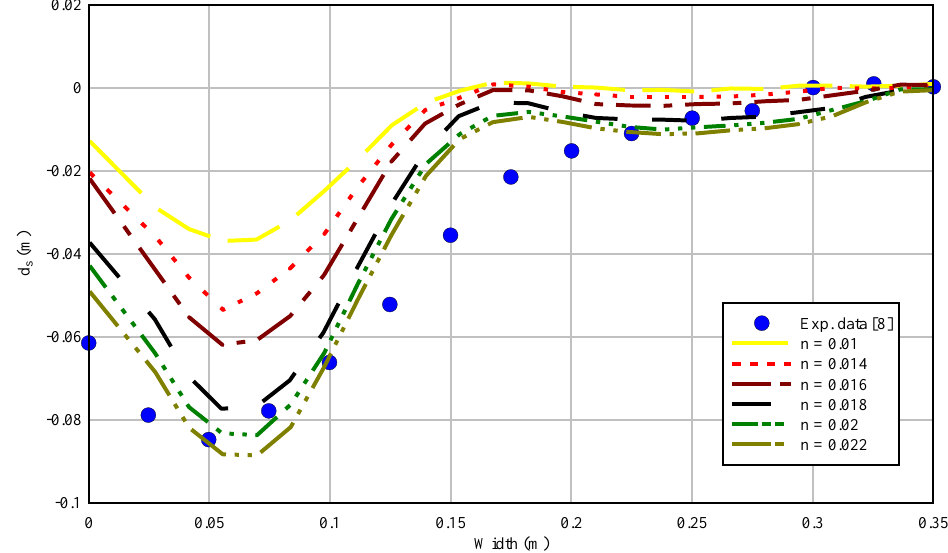
Figure 4. Comparison between experimental data and simulated bed profiles for different roughness coefficients.